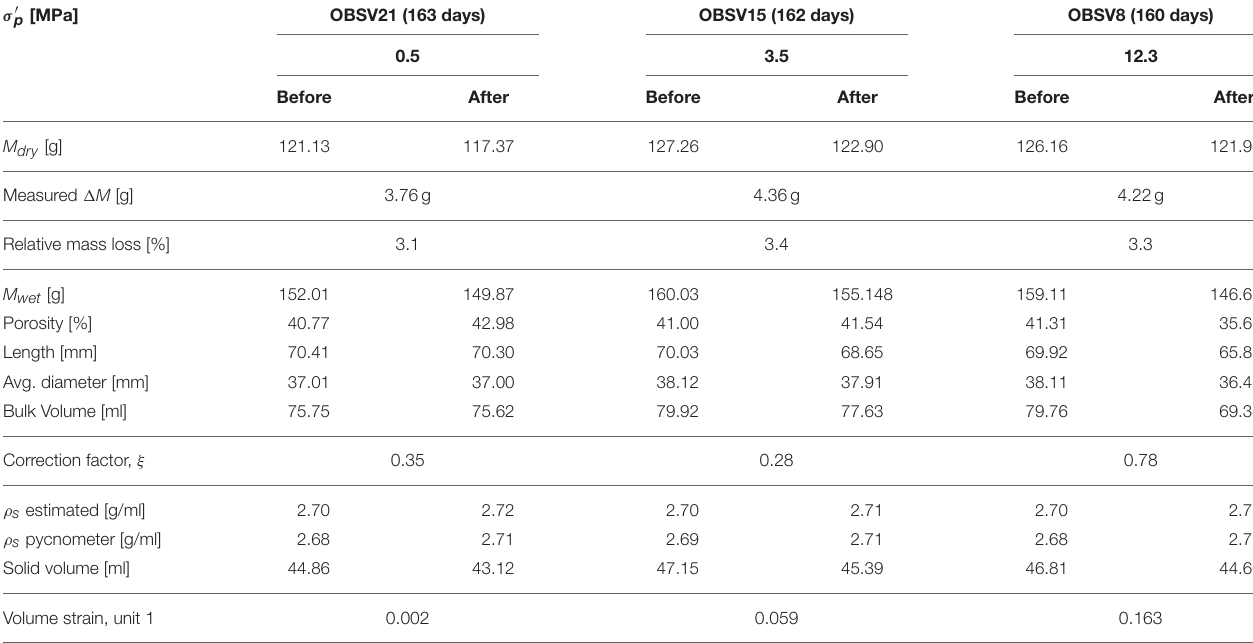
TABLE 1 | Basic quantities of the 130 ◦ C experiments. σ ′ p [MPa]